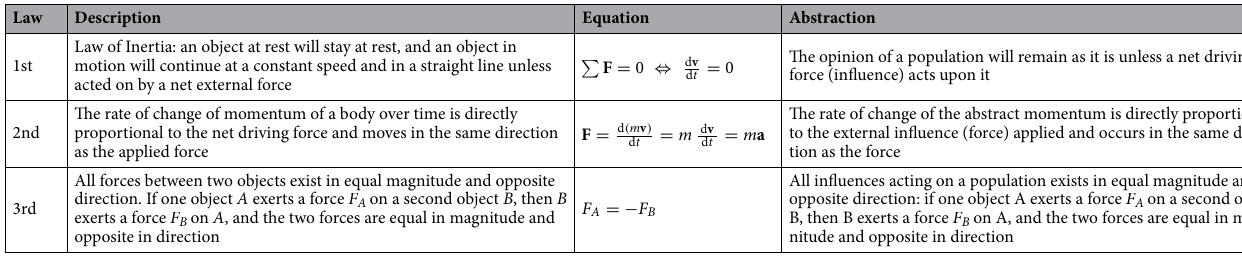
Table 2. Newton’s Laws and an abstraction.